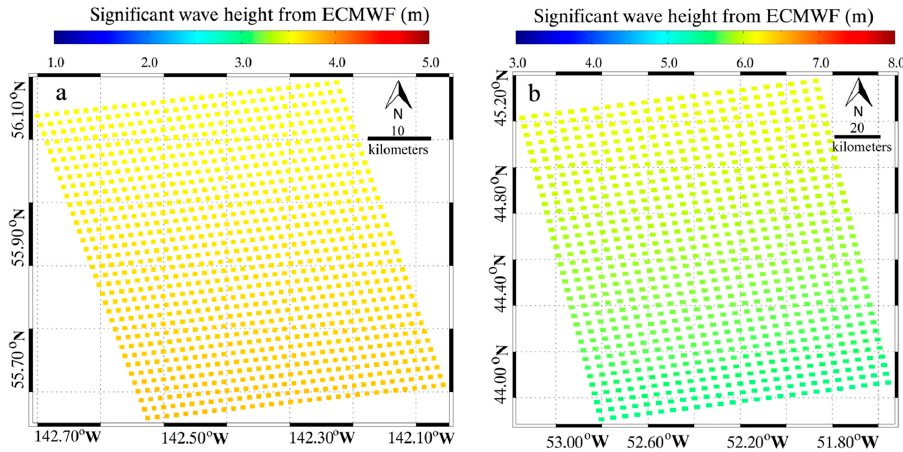
Figure 2. ( a ) Space and time interpolated European Centre for Medium-Range Weather Forecasts (ECMWF) SWH data corresponding to the SAR image in Figure 1a; and ( b ) same as ( a ) but for the SAR image in Figure 1b.